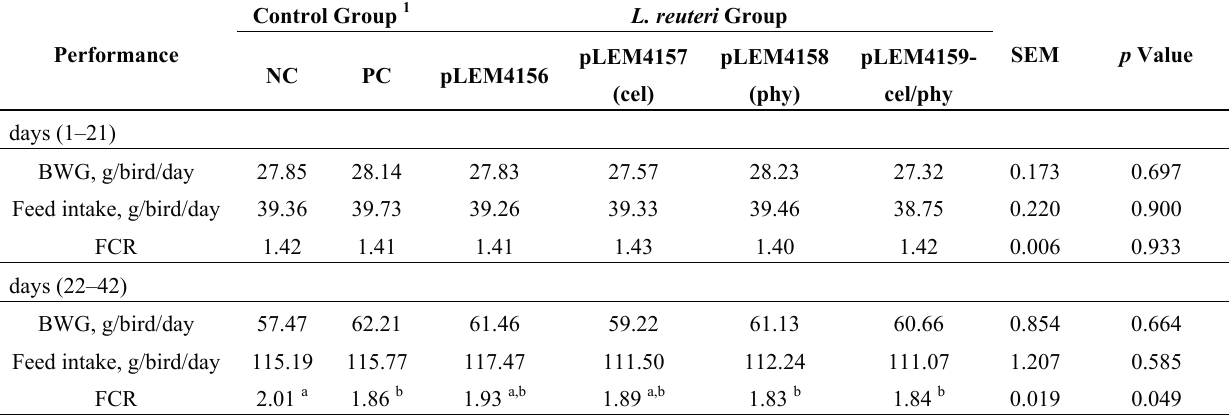
Table 2. Effects of transformed L. reuteri strain supplementation on growth performance of